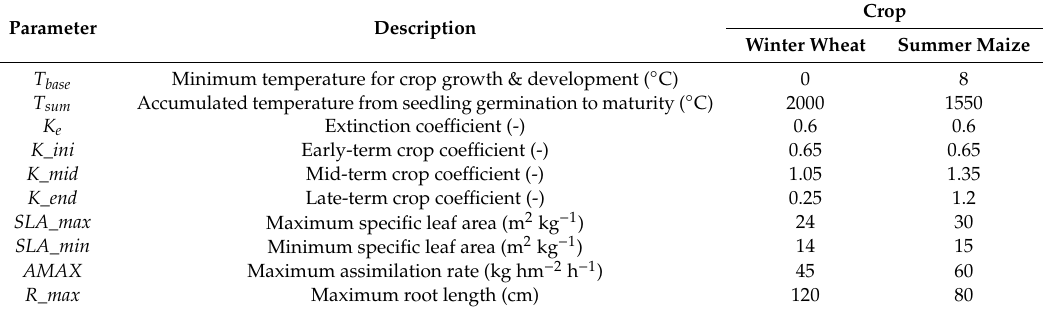
Table A4. Parameters for original crop species used in the WHCNS model [30].